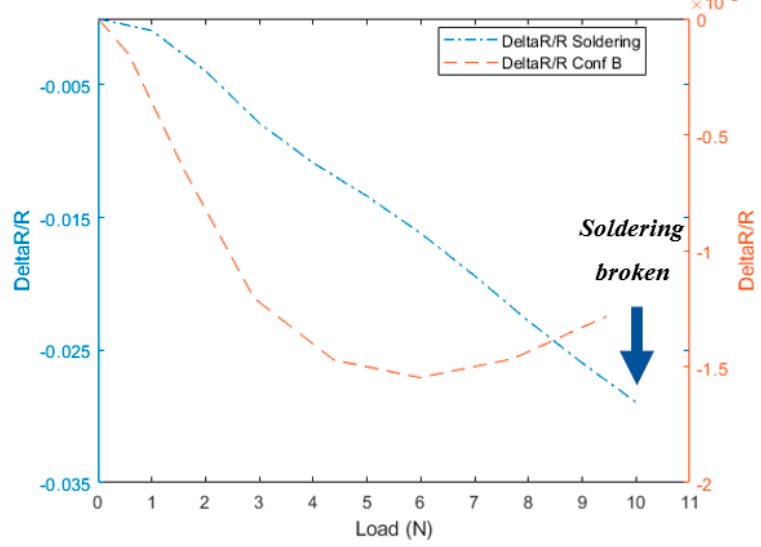
Figure 6. The tensile test for 1 K and the corresponding resistance variation measurements for configuration C.